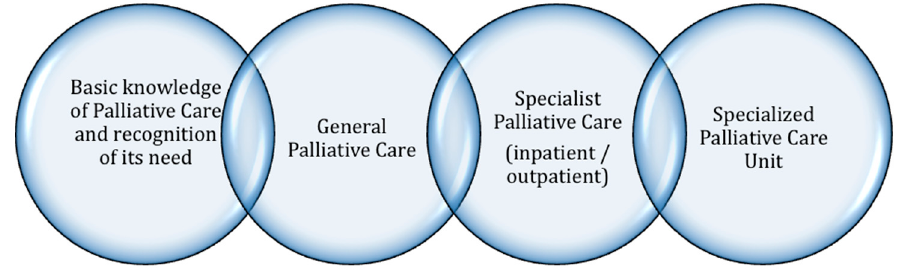
Figure A1. The Chain of Palliative Care (from Bollig 2010) [8].